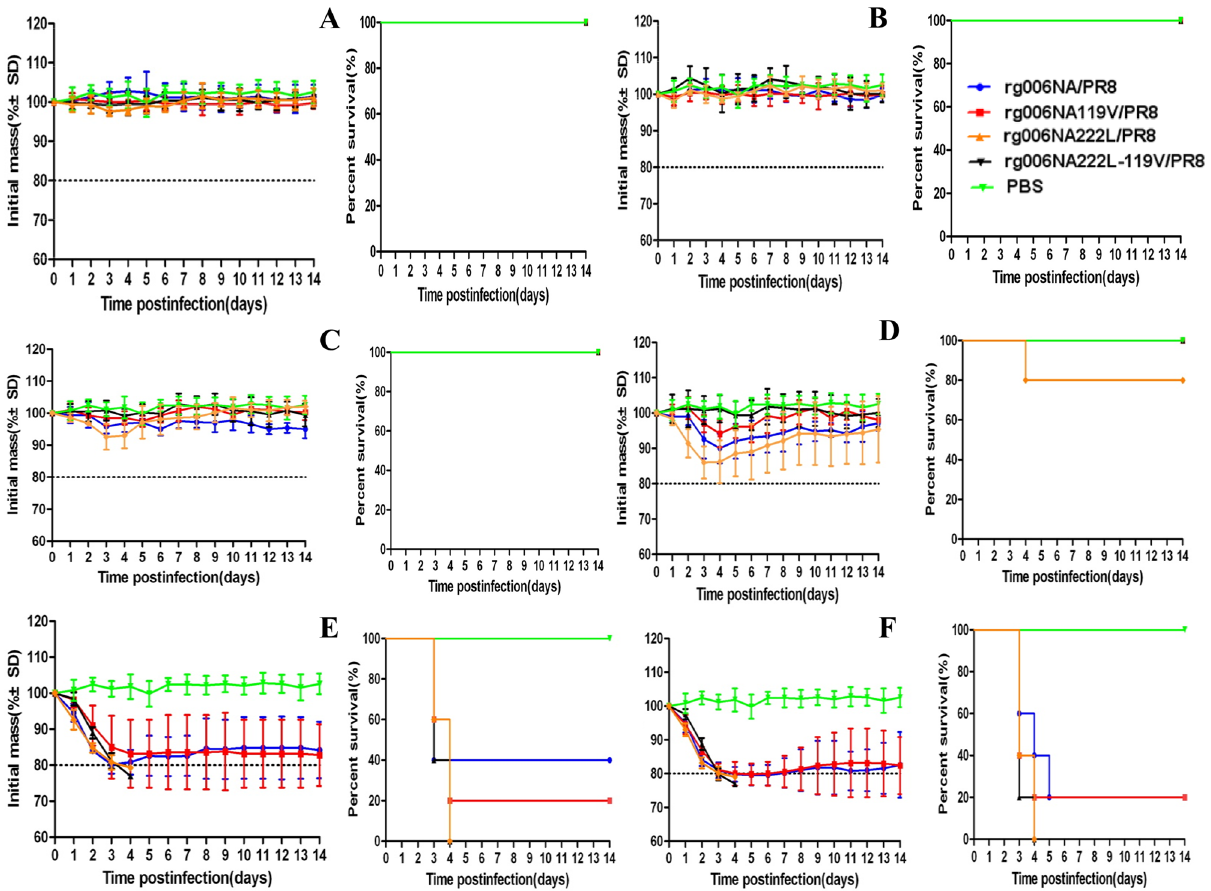
Figure 2. Body weight curve and survival condition of mice infected with different doses of H7N9/PR8 recombinant viruses. Body weight change and survival condition of C57BL/6 mice (n = 5/group) inoculated intranasal with 10 1 –10 6 TCID 50 recombinant H7N9/PR8 viruses. Control group: PBS. ( A ) 10 1 TCID 50 ; ( B ) 10 2